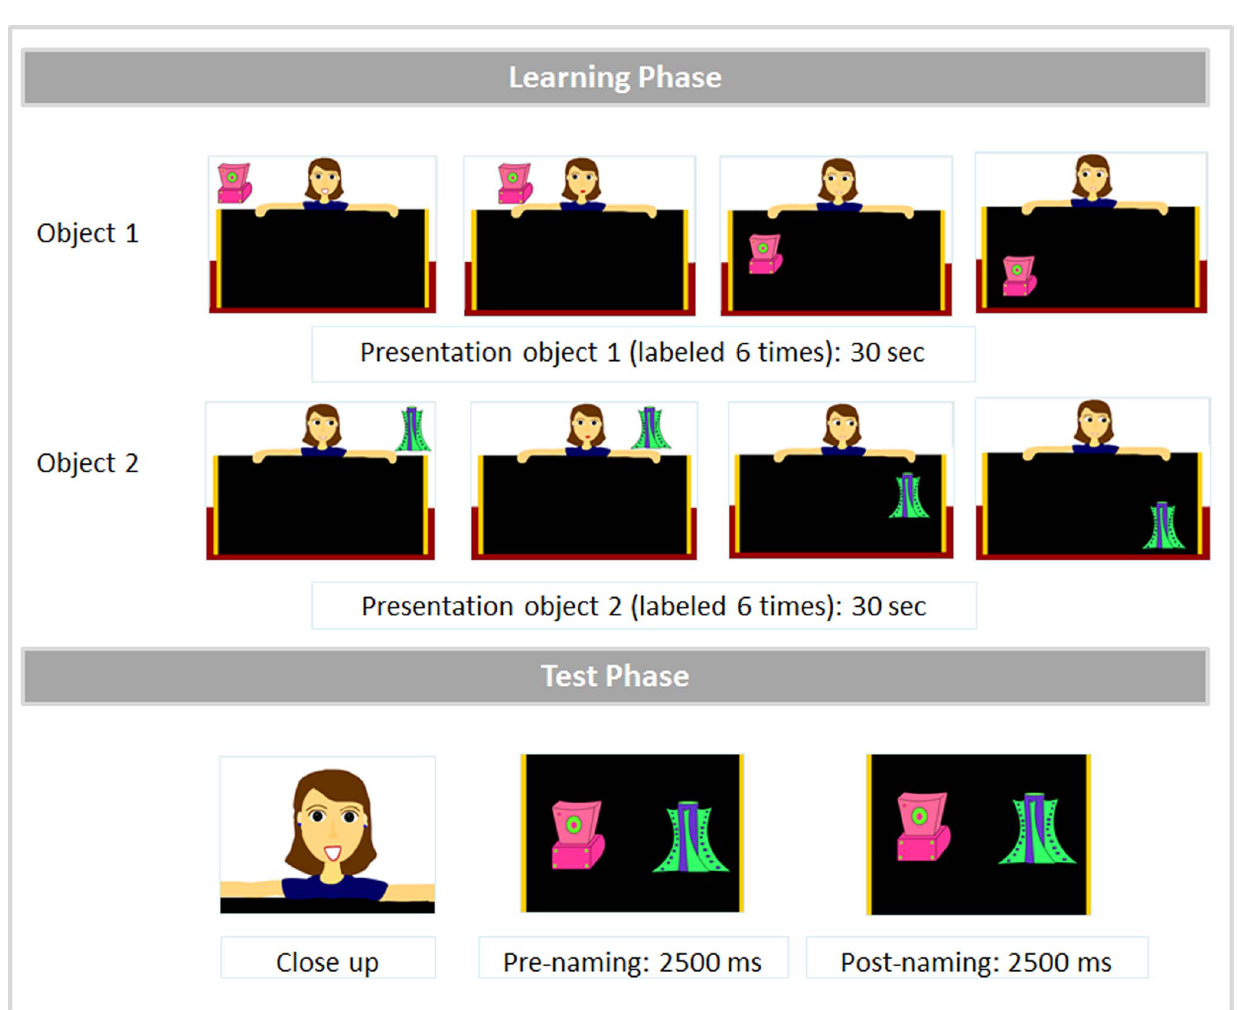
Figure 2. Structure of a word-learning cartoon.